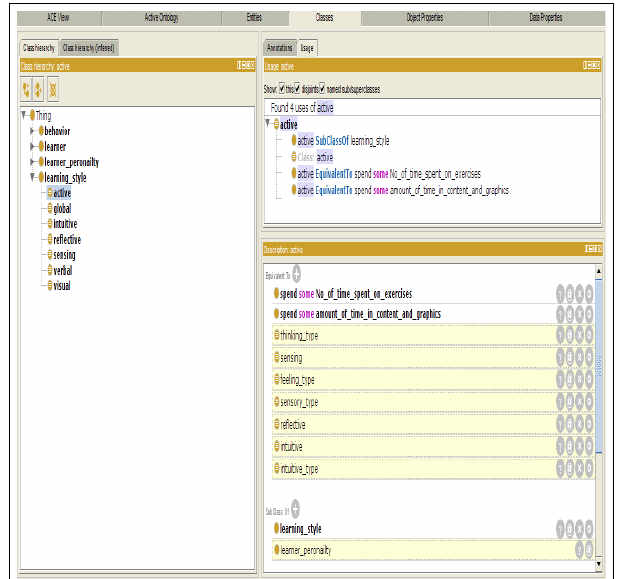
Figure 12. learning style